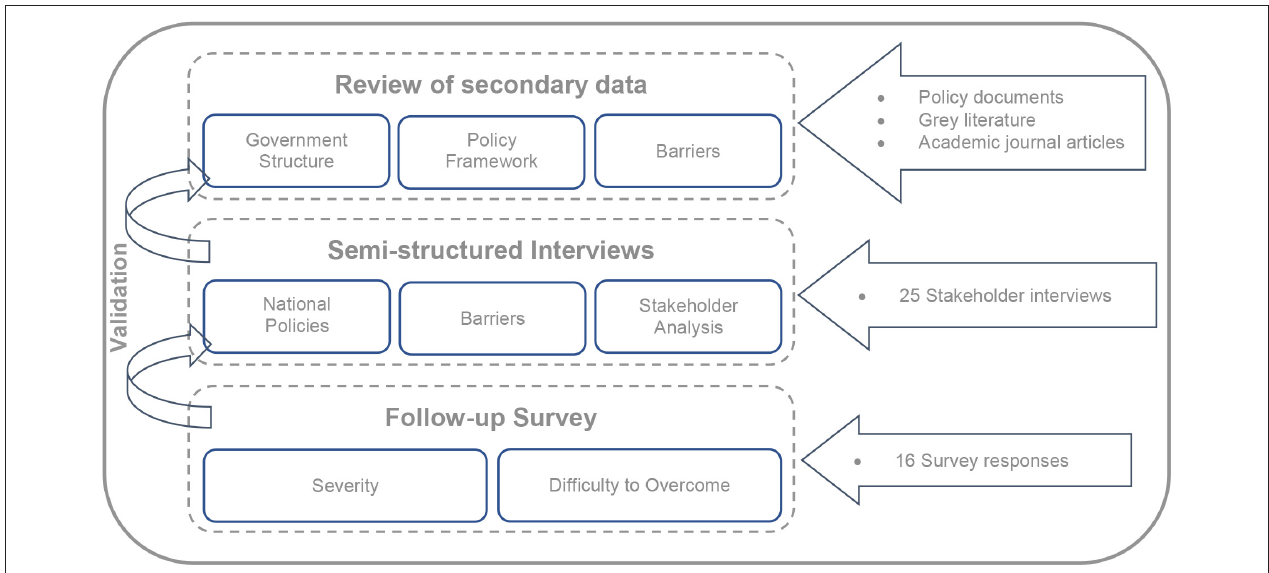
FIGURE 1 | Stages of the survey process. Review of secondary data on policies, institutions, and barriers was followed by semi-structured interviews with the key actors to identify barriers and then Quantitative surveys to evaluate severity and difficulty to overcome them.